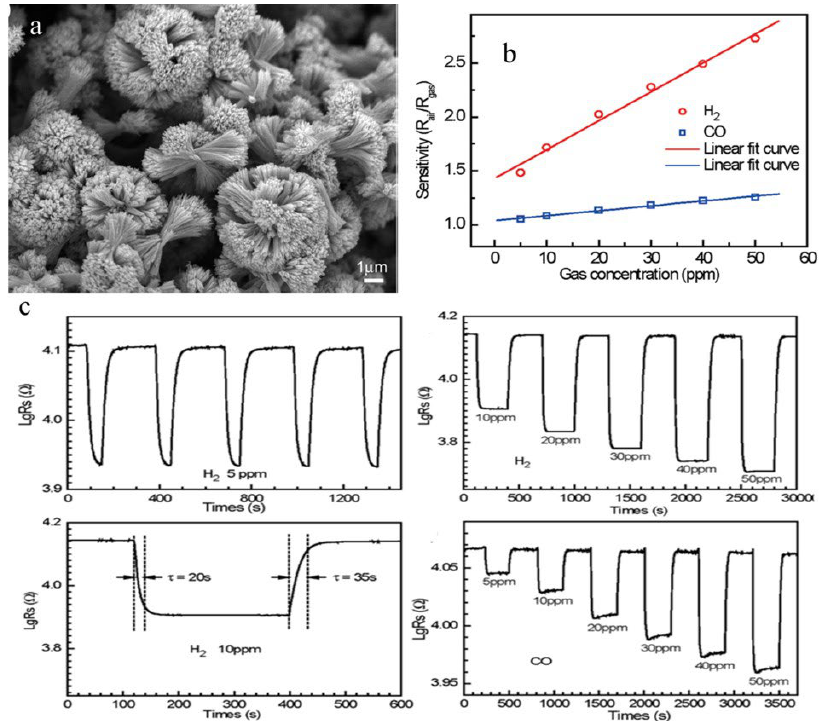
Figure 12. ( a ) SEM image of SnO 2 microstructure. ( b ) Linear dependence relation between resistance response sensitivity and gas concentration. ( c ) Exposure of SnO 2 microstructure to H 2 for gas sensing depicts the change in concentration of H 2 and its effect on sensor response, the response and recovery times for H 2 at 10 ppm, and the variation of sensor response with change in concentration of CO. (Reprinted with permission from [76]. Copyright 2009, American Chemical Society, Washington, DC, USA).